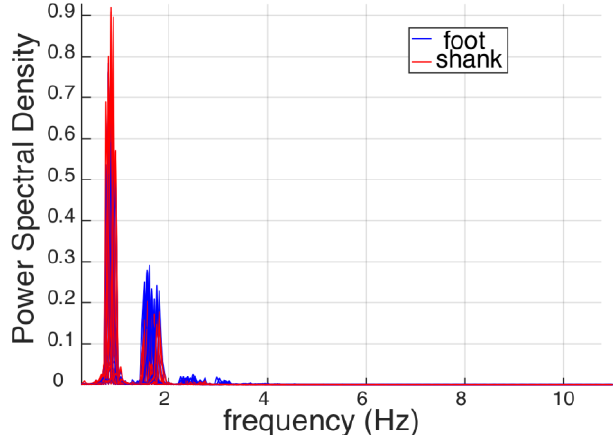
Figure 7. Power spectral density of the elevation angles of the perturbed foot (blue lines) and perturbed shank (red lines). Signals of each subject and each trial are superimposed.